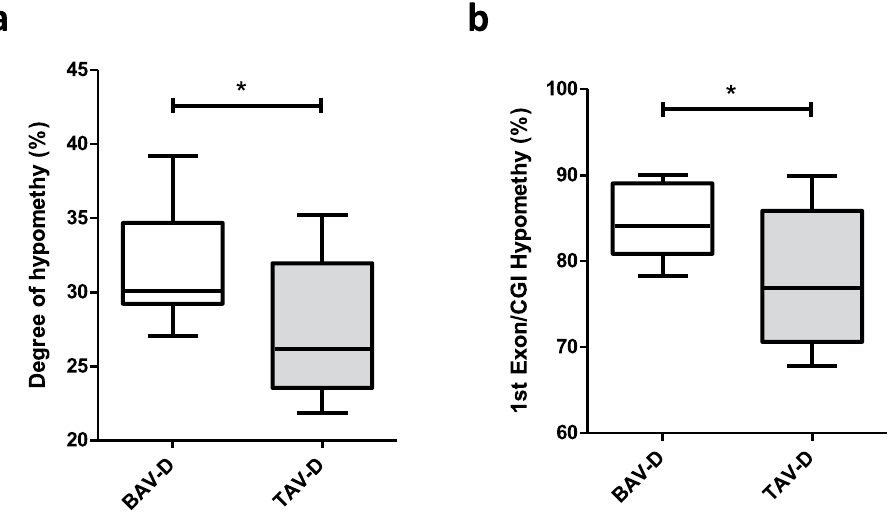
Figure 1. Hypomethylation in BAV and TAV dilated (D) aortas. Degree of ( a ) hypomethylation and ( b ) hypomethylation of CpG-island within the 1 st exon. N = 14 BAV and N = 13 TAV (t-test). Data is expressed as (%) ± standard deviation. * P ≤